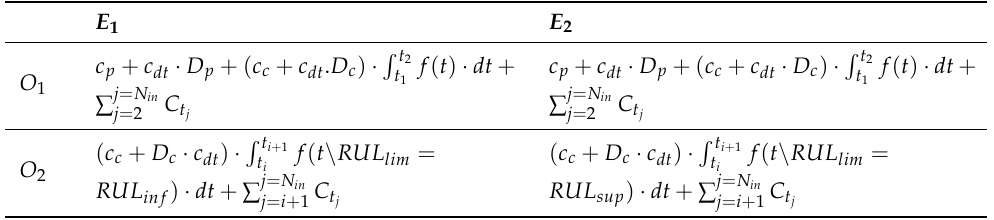
Table 1. Conditional results of the different combinations decision option—event. E